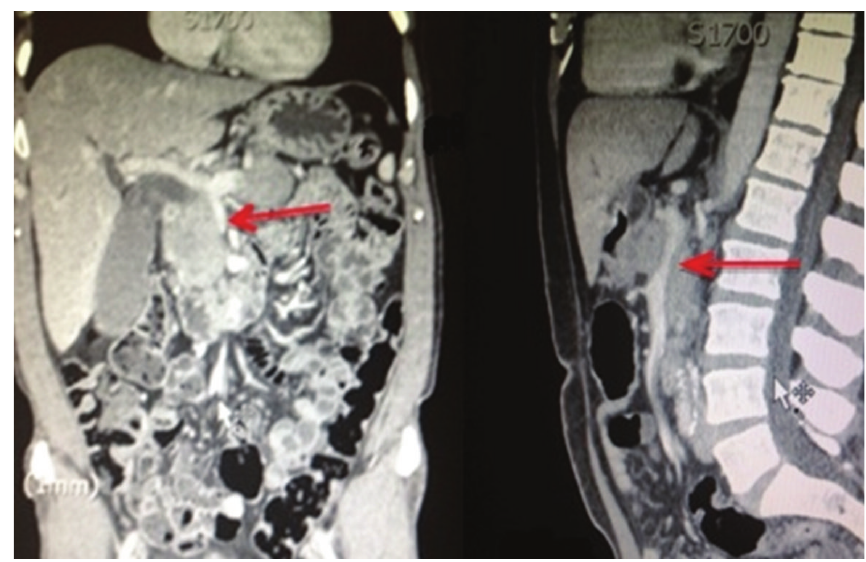
Figure 3: Portal vein narrowed with evidence of impingement on CT axial and sagittal images.